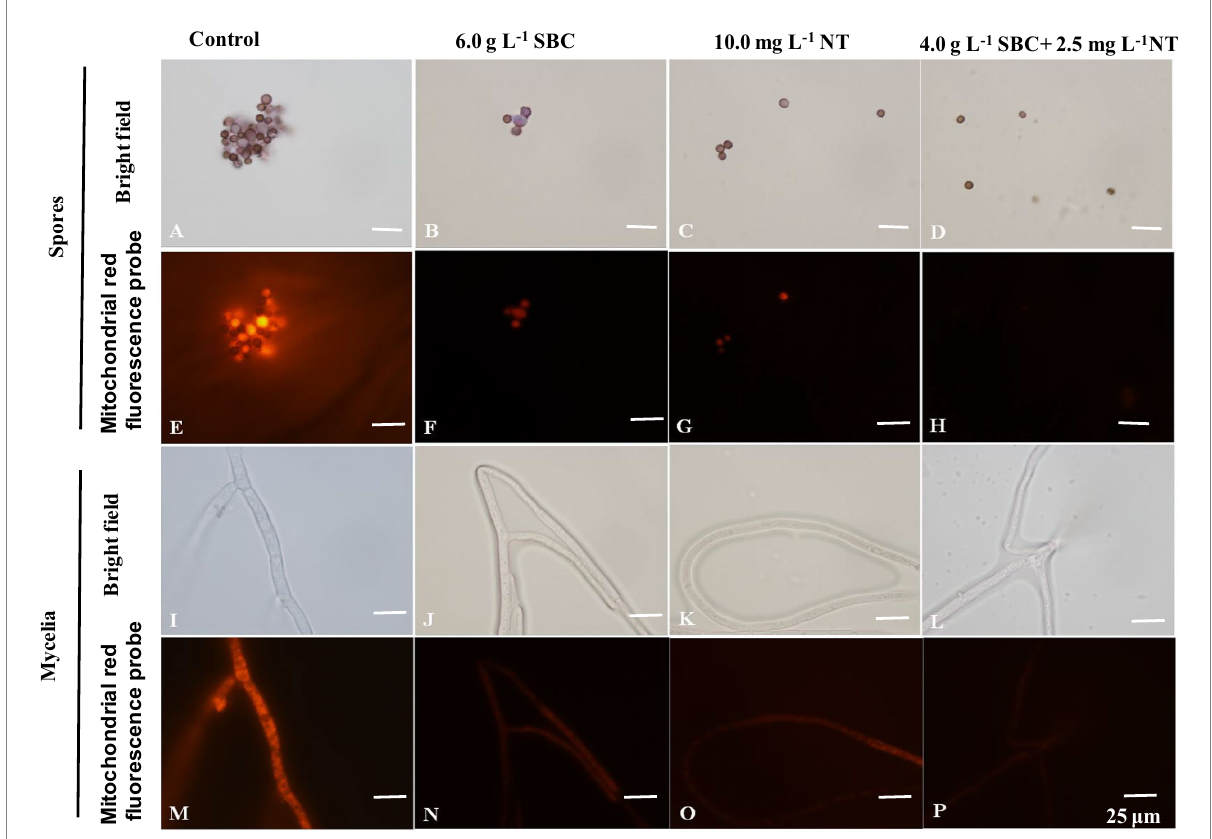
FIGURE 10 Aspergillus niger stained with the mitochondrial red fluorescence probe after treatment with SBC or NT. (A,E) Spores in the control; (B,F) spores treated with 6.0 g/L SBC; (C,G) spores treated with 10.0 mg/L NT; (D,H) spores treated with 4.0 g/L SBC + 2.5 mg/L NT; (I,M) mycelia in control; (J,N) mycelia treated with 6.0 g/L SBC; (K,O) mycelia treated with 10.0 mg/L NT; (L,P) mycelia treated with 4.0 g/L SBC + 2.5 mg/L NT mycelia. Images were obtained by microscopy at 1,000× magnification, bar = 25 μ